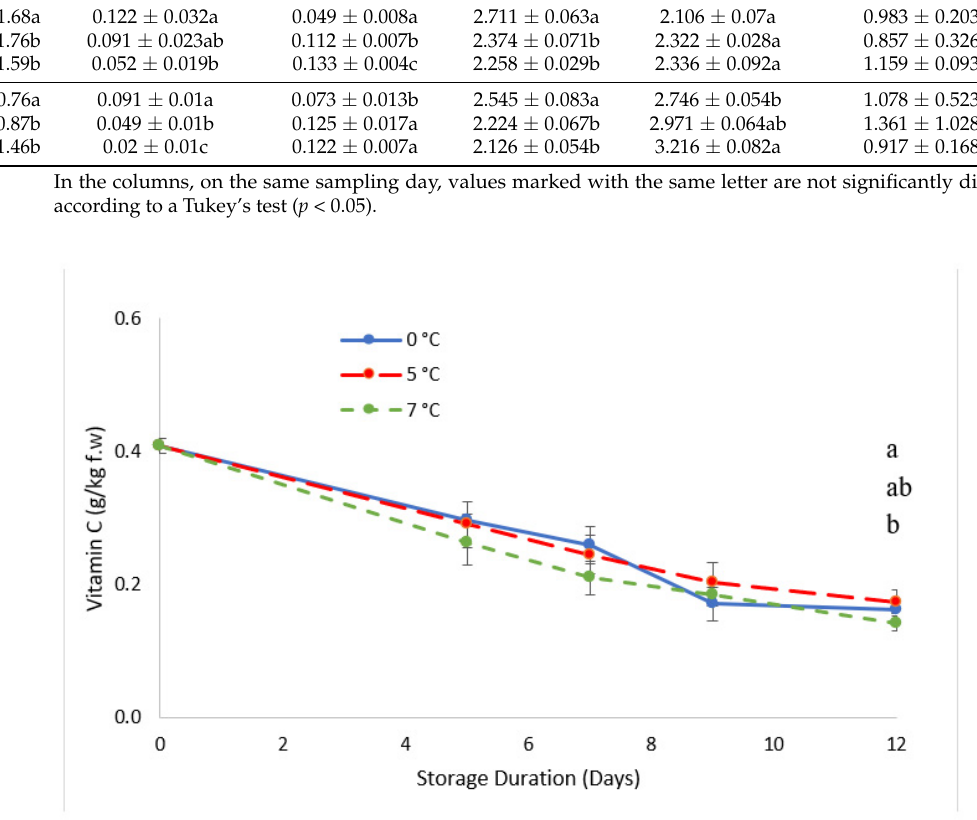
Figure 6. Changes in vitamin C levels during storage. Values marked with the same letter on the same harvest day are not significantly different according to a Tukey’s test ( p < 0.05).